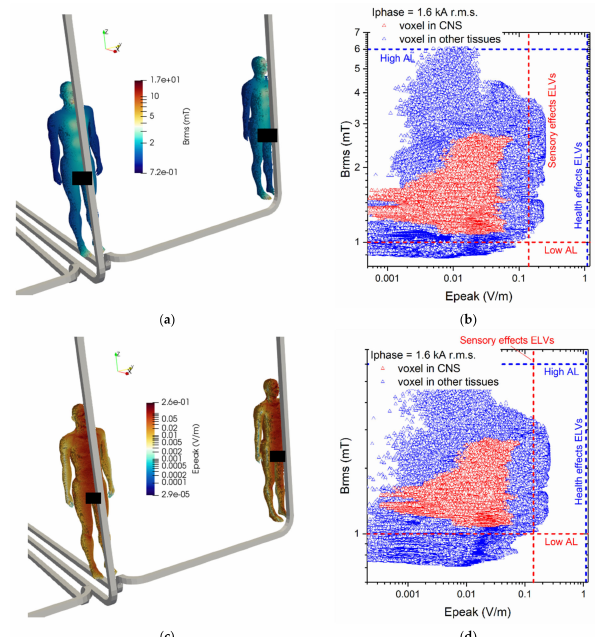
Figure 15. Results for posture C.1. On the upper left ( a ) the spatial distribution of the B-field amplitude (r.m.s. values, in millitesla) over the body surface for the two body positions. On the lower left ( b ) the corresponding spatial distribution of the E-field amplitude (peak values, in volt per metre) over the body surface. On the right the distributions of the voxel values: upper diagram ( c ) corresponding to the posture C.1a, lower diagram ( d ) corresponding to the posture C.1b.